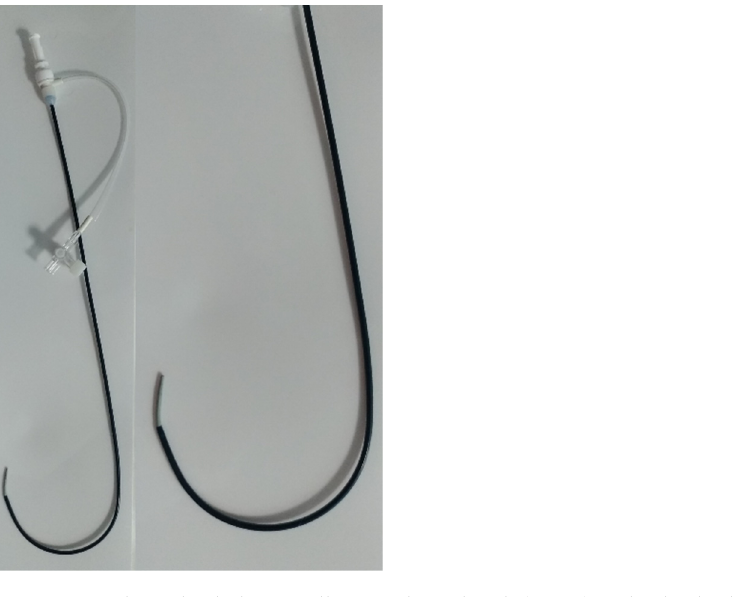
Figure 2. Cook Medical Flexor Balkin Guiding Sheath (5.5 Fr) with Check-Flo Valve and hydrophilic coating. On the right, magnification of the 180° curve guiding sheath.